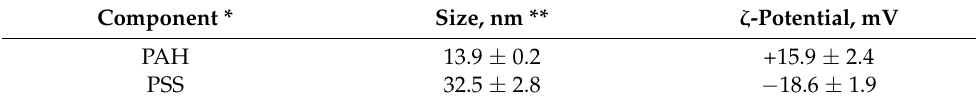
Table 2. Characteristics of the building blocks for the preparation of microcapsules.